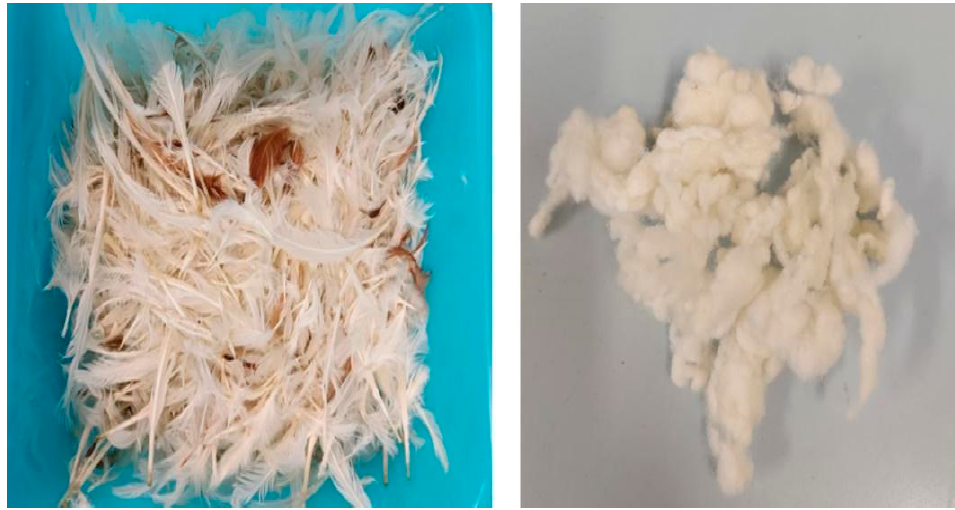
Figure 2. Waste as received: chicken feathers ( left ) and sheep wool ( right ).